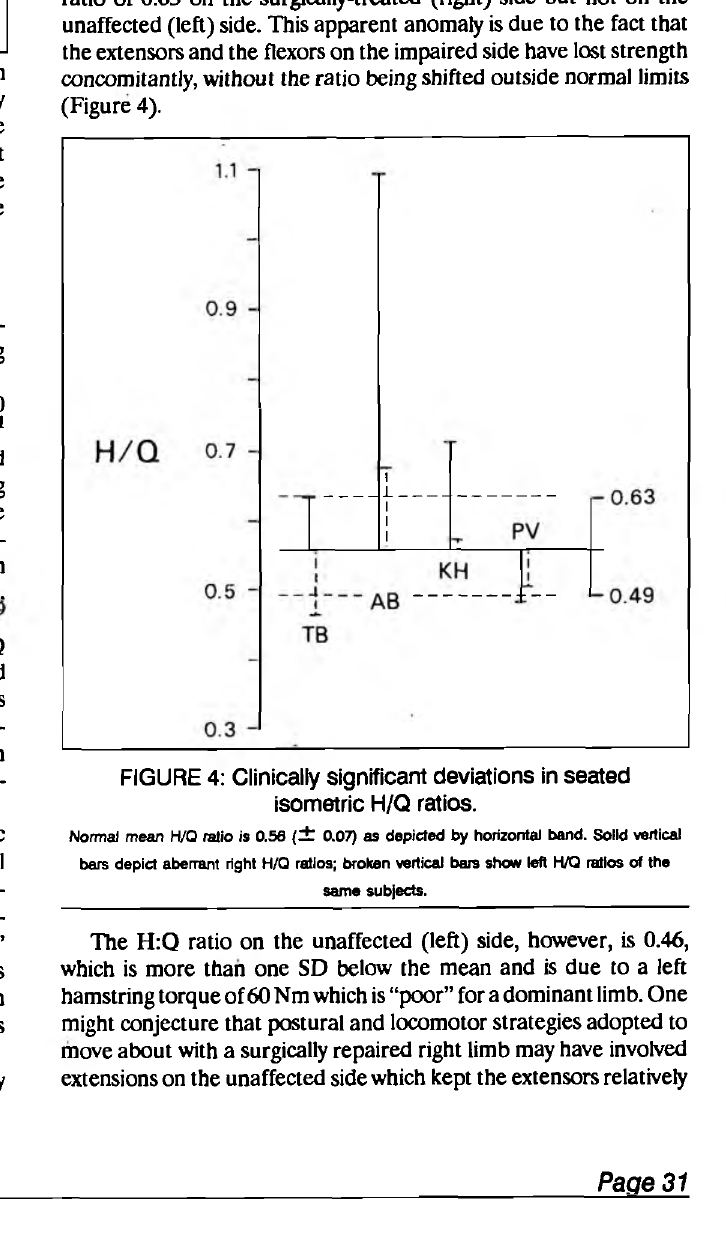
FIGURE 4: Clinically significant deviations in seated isometric H/Q